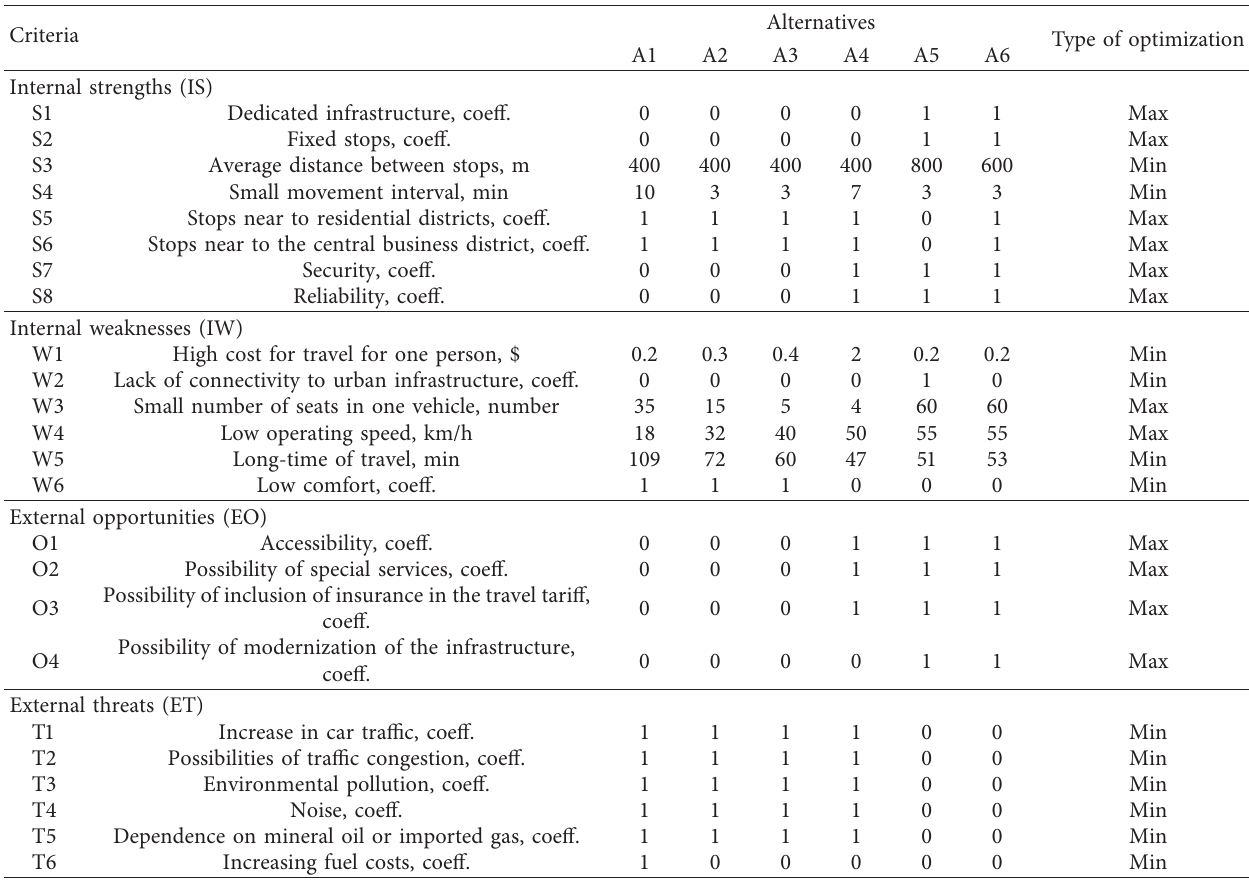
Table 11: Values of the criteria (type of optimization).